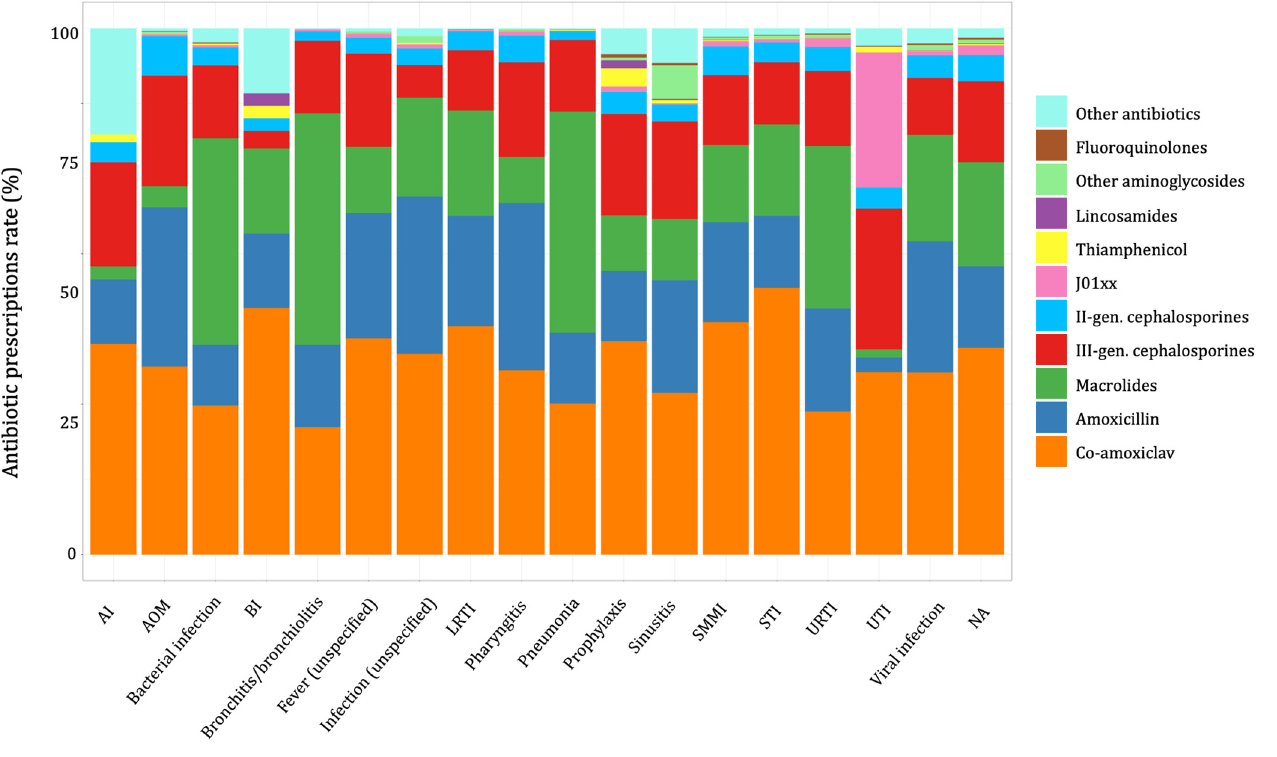
Figure 5. Antibiotic prescriptions’ prevalence rates, stratified by diagnosis class (Pedianet, 2012–2018). AOM = acute otitis media; URTI = upper respiratory tract infection; LRTI = lower respiratory tract infection; UTI = urinary tract infection; SMMI = skin and mucus membrane infection; STI = soft tissue infection; BI = bone infection; AI = abdominal infection.